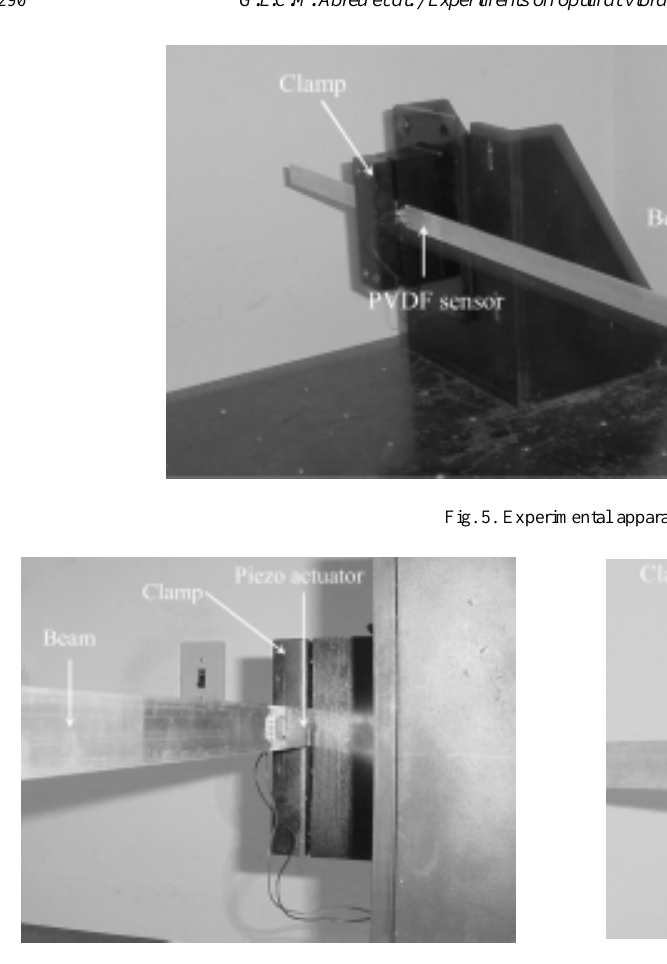
Fig. 6. Piezoelectric actuator location. Fig. 7. Piezoelectric sensor